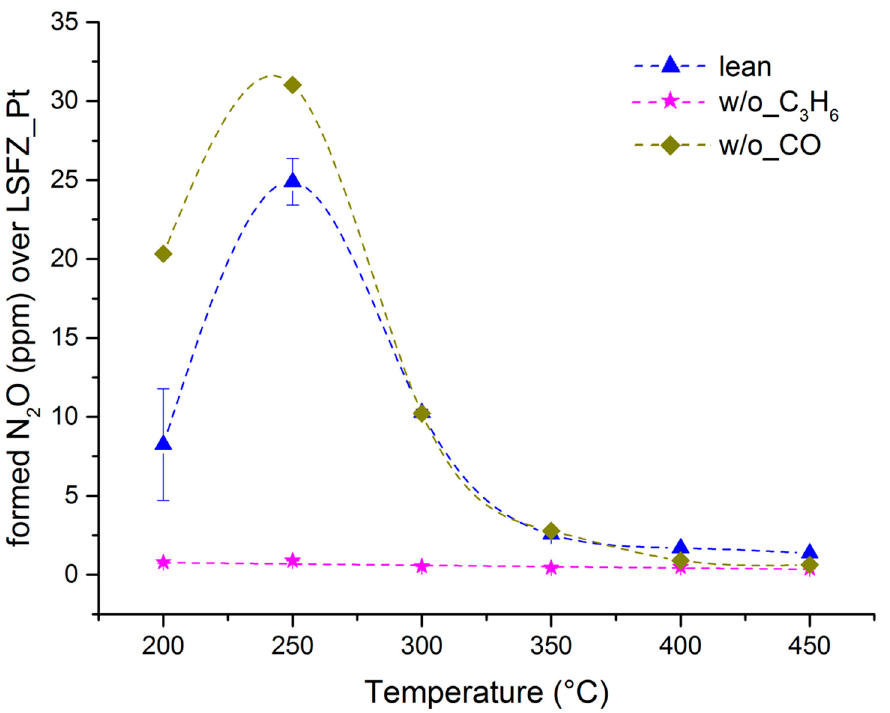
Figure 2. Temperature dependence of N 2 O formation over LSFZ_Pt in different synthetic exhaust